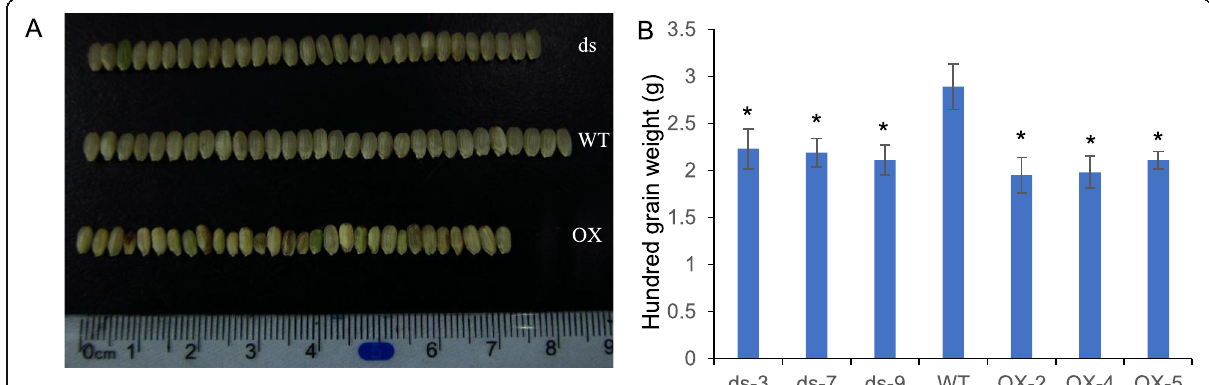
Fig. 1 Phenotypic analysis of SDG711 transgenic seeds. a. Smaller mature seeds of SDG711 RNAi and overexpression transgenic plants. Bars = 0.5 cm. ds indicates independent lines of SDG711 RNAi transgenic plants; OX indicates independent lines of SDG711 overexpression transgenic plants. b . The 100-grain weight of SDG711 RNAi, overexpression transgenic plants, and wild type. *significantly different ( p < 0.01). Values are mean ± SD. ds3, ds-7 and ds-9 indicate independent lines of SDG711 RNAi transgenic plants; OX-2, OX-4, and OX-5 indicate independent lines of SDG711 overexpression transgenic